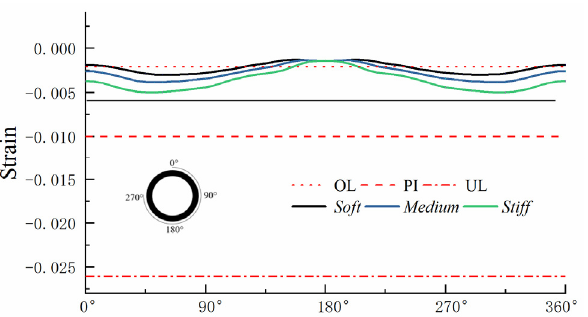
Figure 15. Axial strain distribution curves of peak strain sections of steel tubes with different surrounding rock properties in fault fracture zones ( △ f = 8 cm and β = 60°).